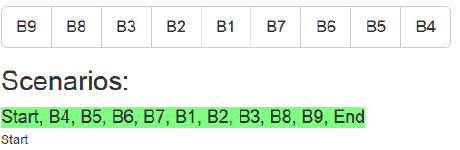
Figure 7. Suggested order of activities for performing the next scenario.